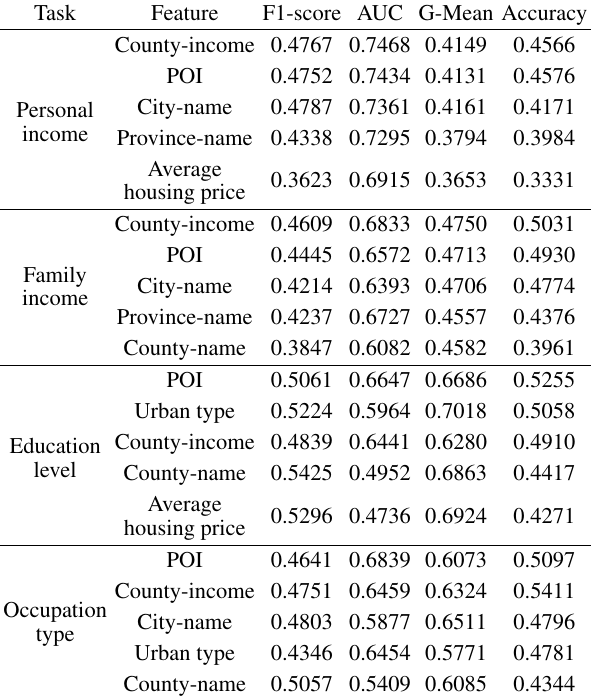
Table 4 Metrics of top 5 features in each task. Task